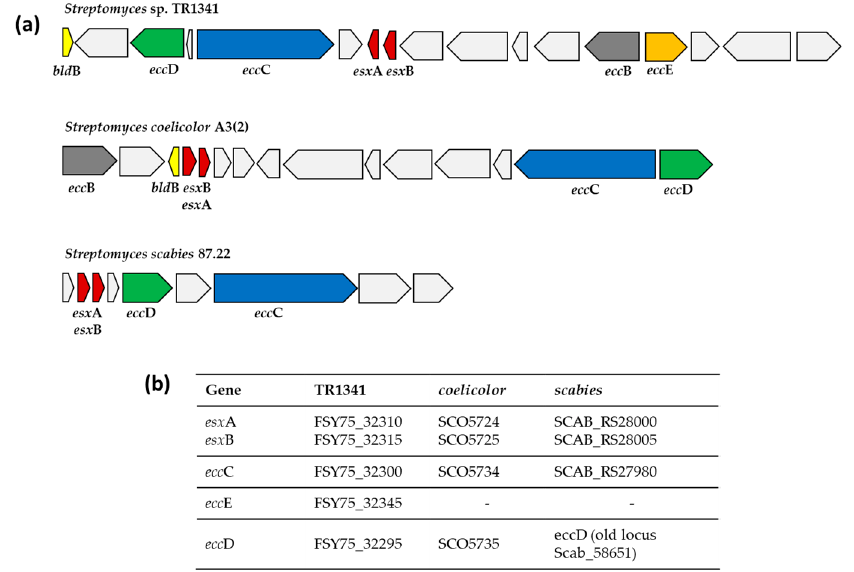
Figure 6. Comparison of type VII secretion system (ESX) present in Streptomyces sp. TR1341 and the ones characterized in Streptomyces coelicolor A3(2) and Streptomyces scabies 87.22. ( a ) Schematic representation of the genomic region of the different type VII secretion systems. ( b ) Genomic locus tags of the main genes.